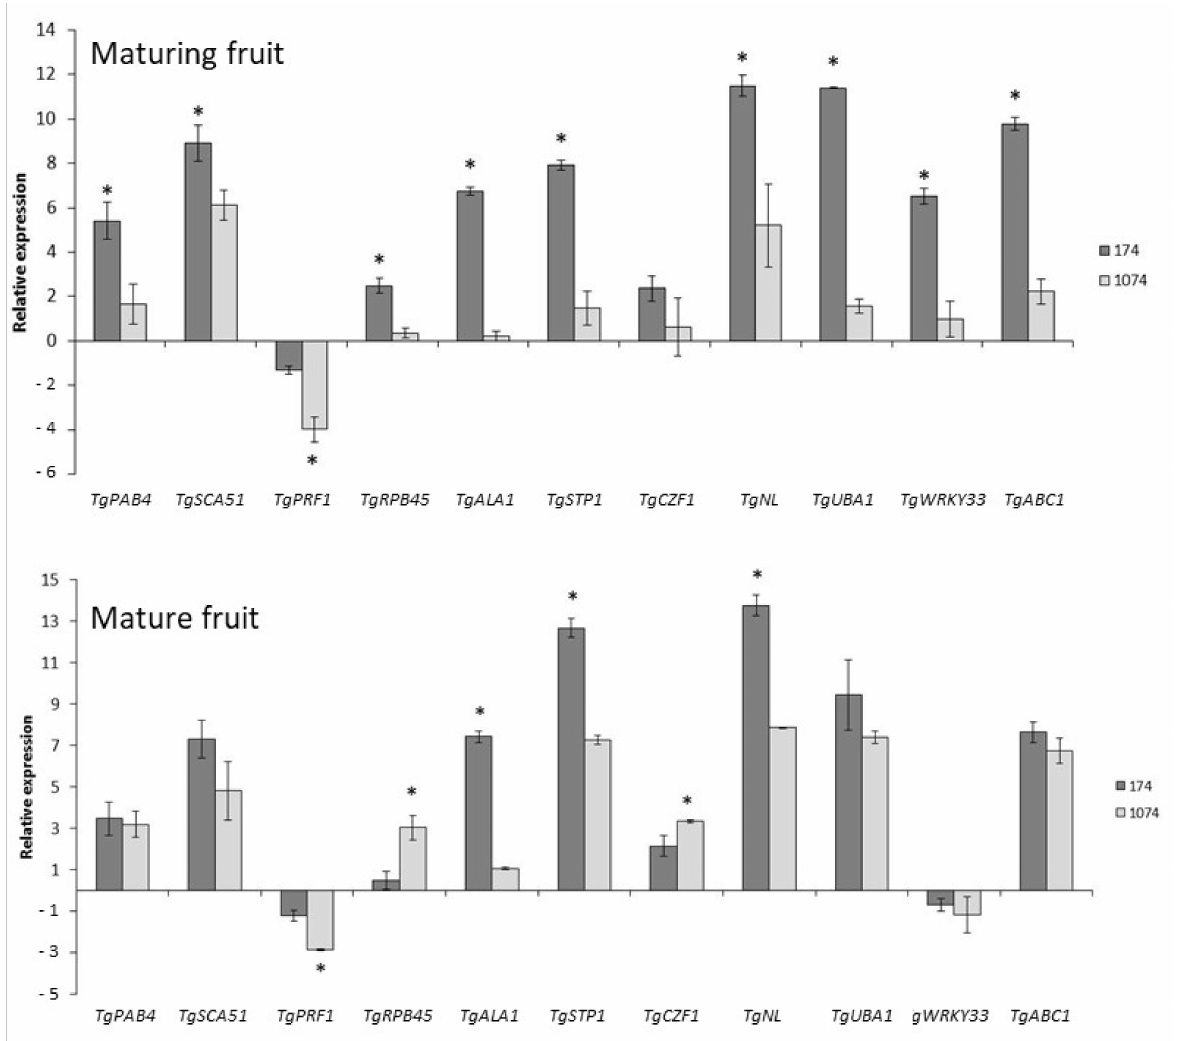
Figure 2. Relative expression of selected genes in pulp samples from young, maturing, and mature fruits of contrasting cupuassu genotypes. (*) indicates significant differences between 174 and 1074 genotype samples by t test ( p ≤ 0.01).